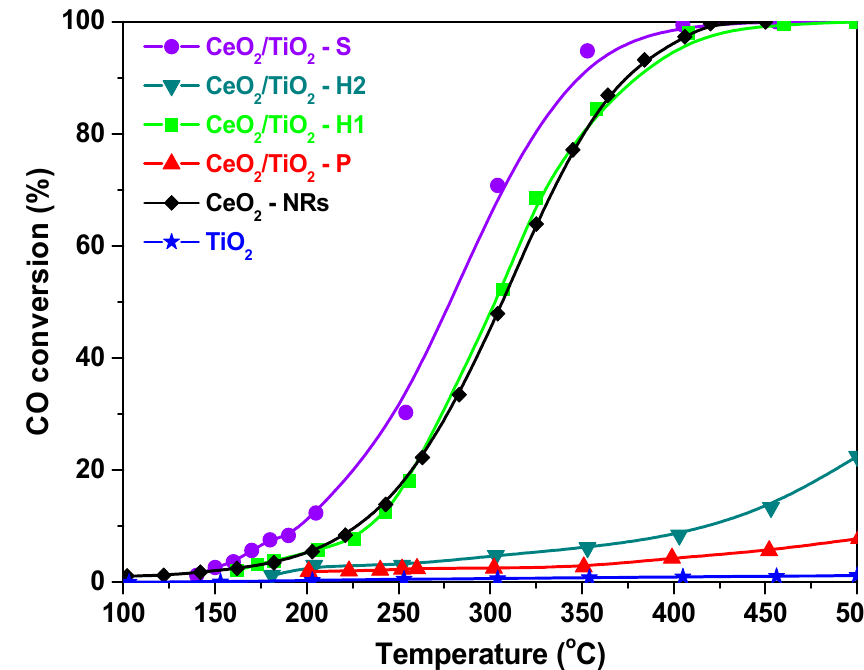
Figure 6. Conversion of CO with temperature for CeO 2 , TiO 2 and CeO 2 / TiO 2 samples. Reaction conditions: 0.2 vol.% CO, 1 vol.% O 2 , GHSV = 40,000 h − 1 .